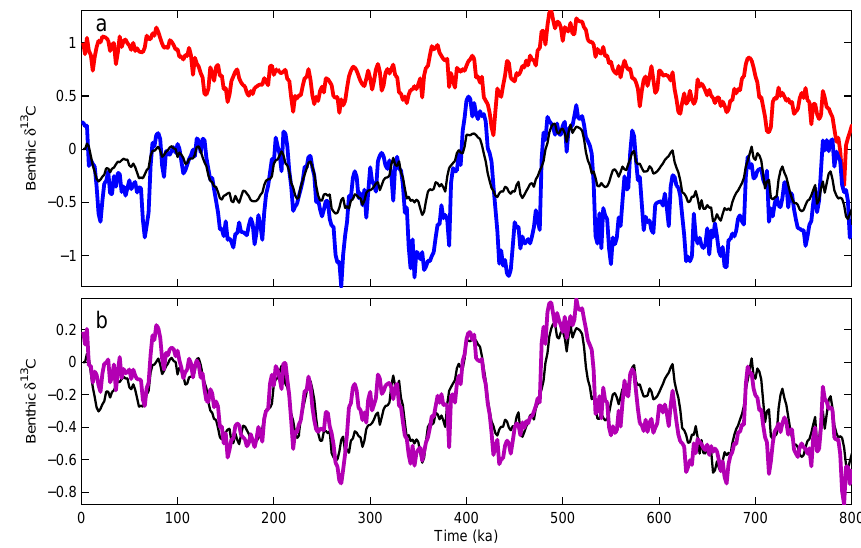
Fig. 2. (a) Regional stacks of δ 13 C for NCW (red), SCW (blue), and PDW (black), (b) PDW δ 13 C stack (black) and the δ 13 C predicted by the null hypothesis (purple), simulated by a constant mixture of 60% NADW and 40% CDW plus a remineralization offset of − 0 . 5‰. This simple mixing model produces a good fit with changes in PDW δ 13 C and the PDW-SCW δ 13 C